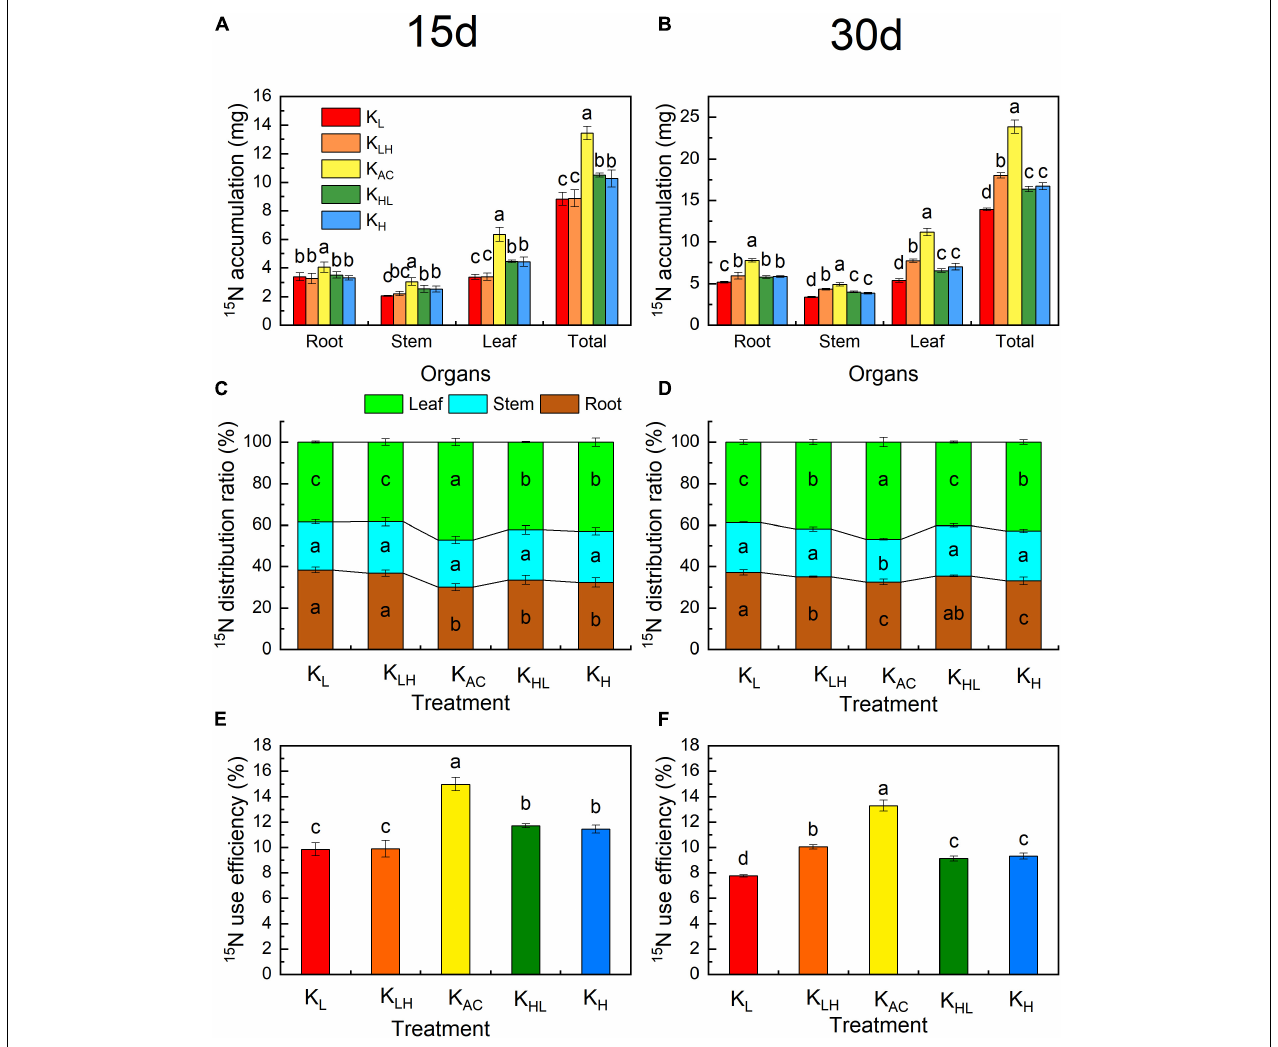
FIGURE 7 | Effects of different K treatments on 15 N accumulation (A) , 15 N distribution ratio (B) and 15 NUE (C) after 15 days treatment and 15 N accumulation (D) , 15 N distribution ratio (E) and 15 NUE (F) after 30 days of M9T337 rootstocks. Data show the means ± standard deviation of three independent samples (three rootstocks as a sample). Different letters on vertical bars indicate significant differences ( P <